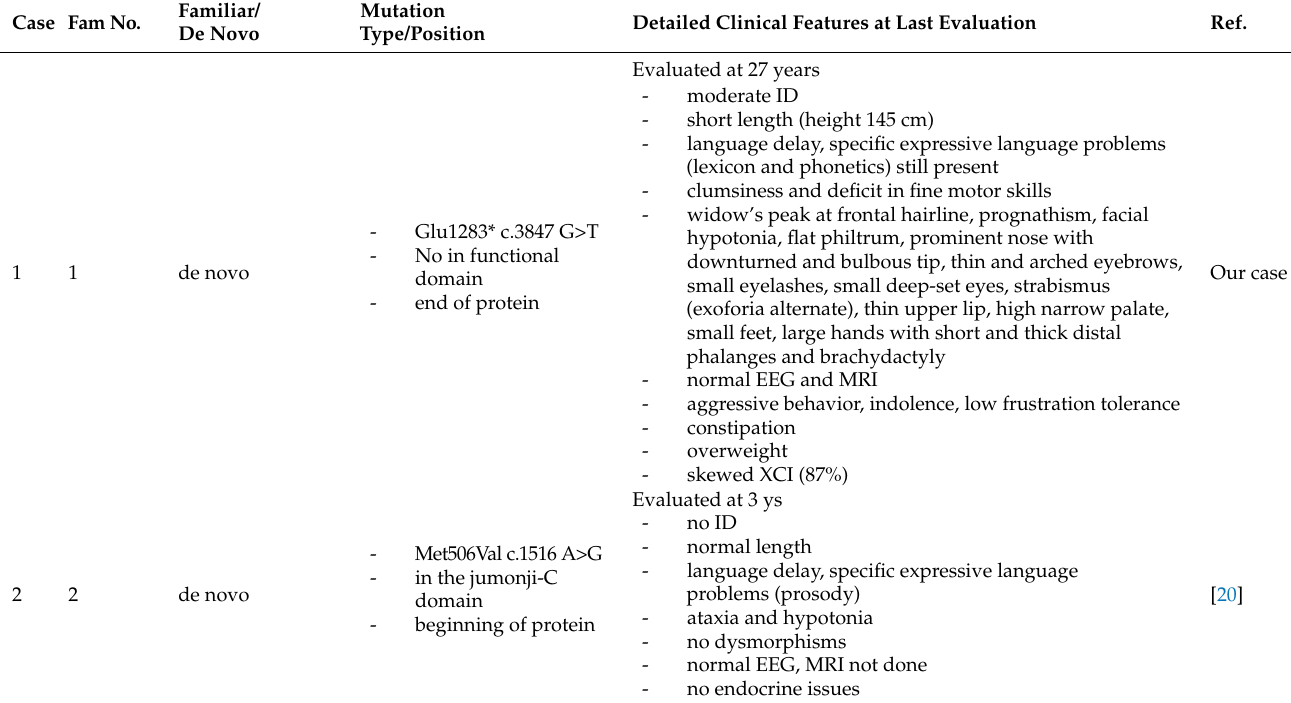
Table 1. Female patients carrying pathogenic KDM5C variants with a detailed clinical history described to date. KDM5C reference: